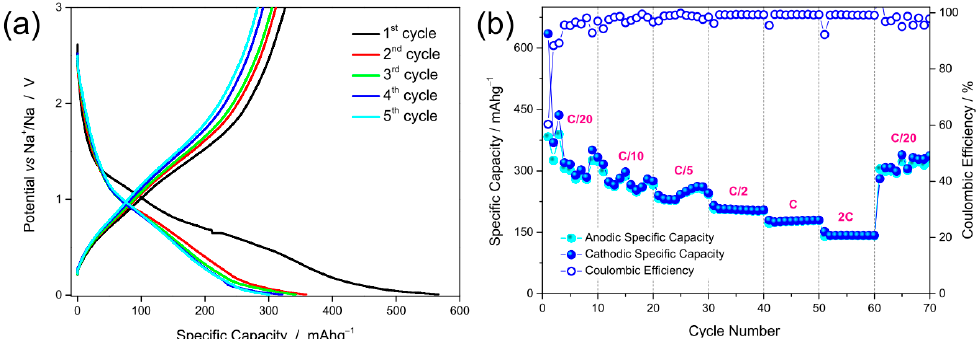
Figure 6. Electrochemical properties of the Fe 2 O 3 :Ge NFs. ( a ) Potential profiles versus the specific capacity and ( b ) anodic and cathodic specific capacities versus number of cycles at different rates and corresponding Coulombic efficiency.